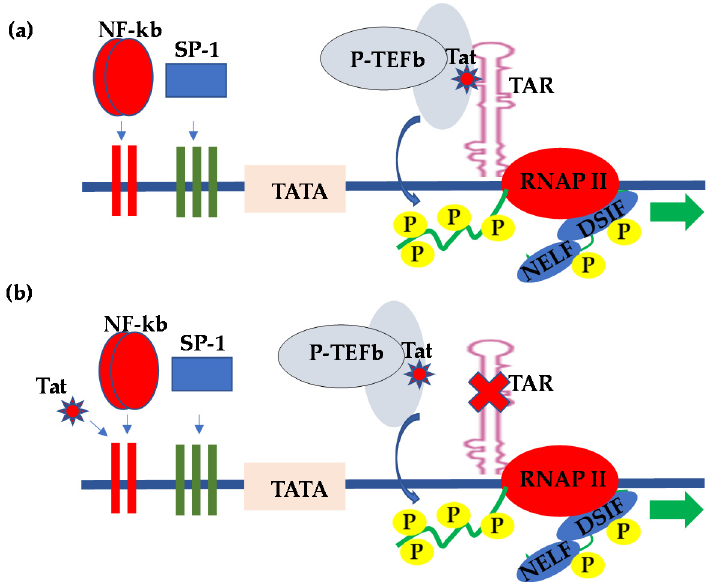
Figure 1. Molecular model for the ( a ) TAR-dependent and ( b ) TAR-independent regulation of HIV transcription.